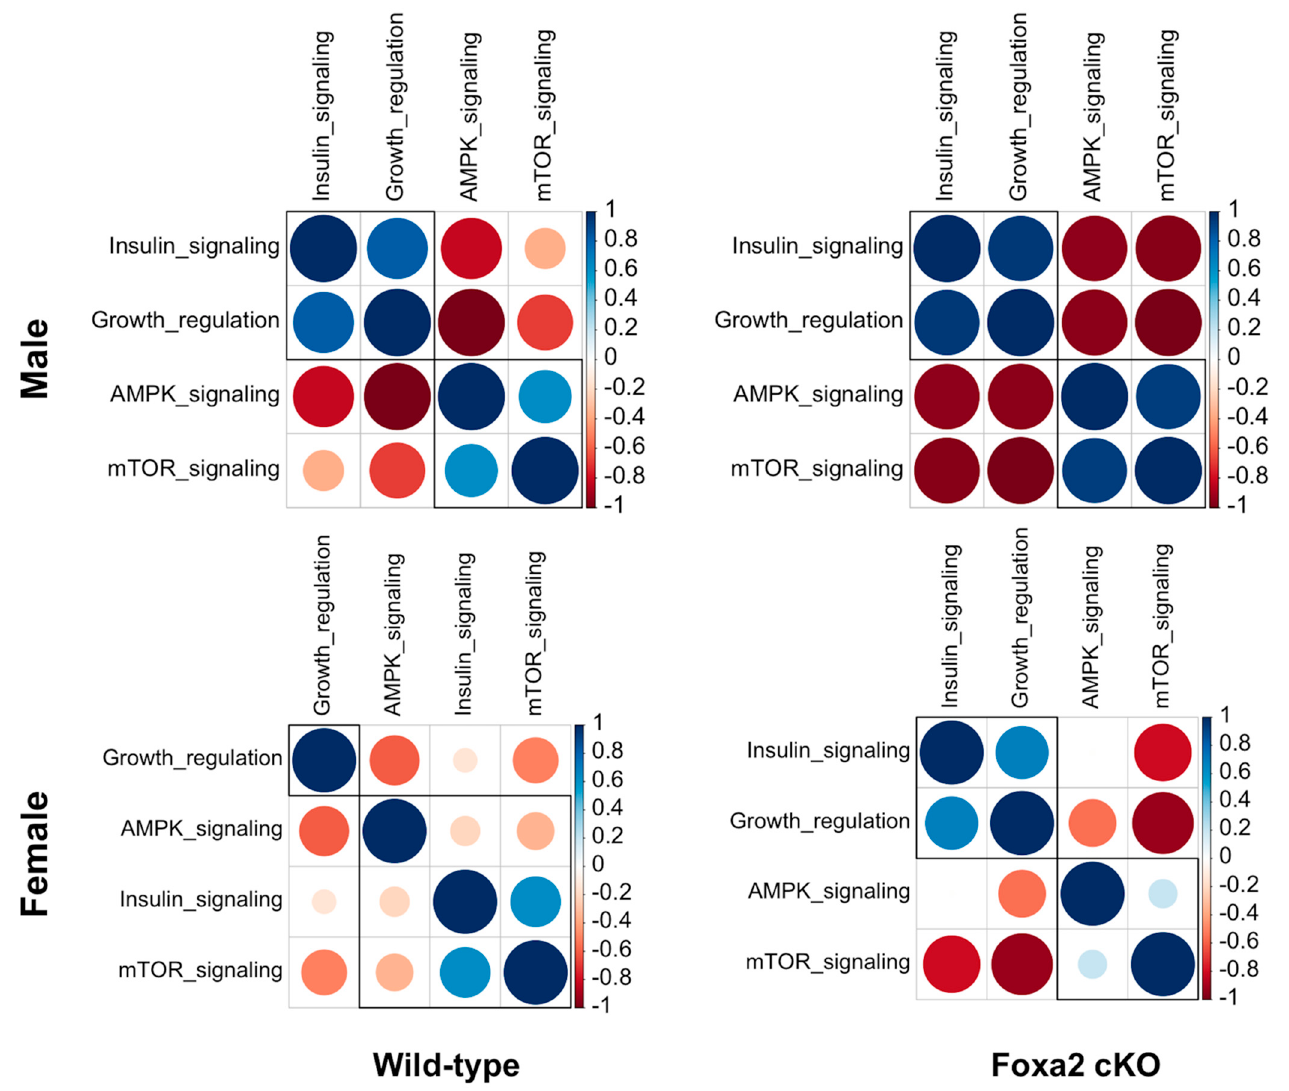
Figure 3. Pair-wise correlation of expression of genes related to the regulation of growth and nutrient sensing and signaling pathways in the brain and placenta male versus female fetuses of the WT and cKO mice (sample size: n = 24). The hierarchical cluster patterns are shown by box. The color-coded scale of correlation levels is shown to the right of each plot.